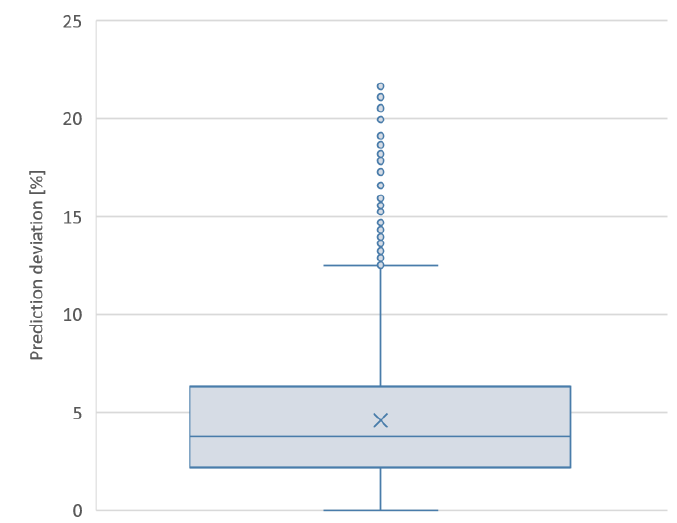
Figure 9. Prediction deviation of the yield strength.